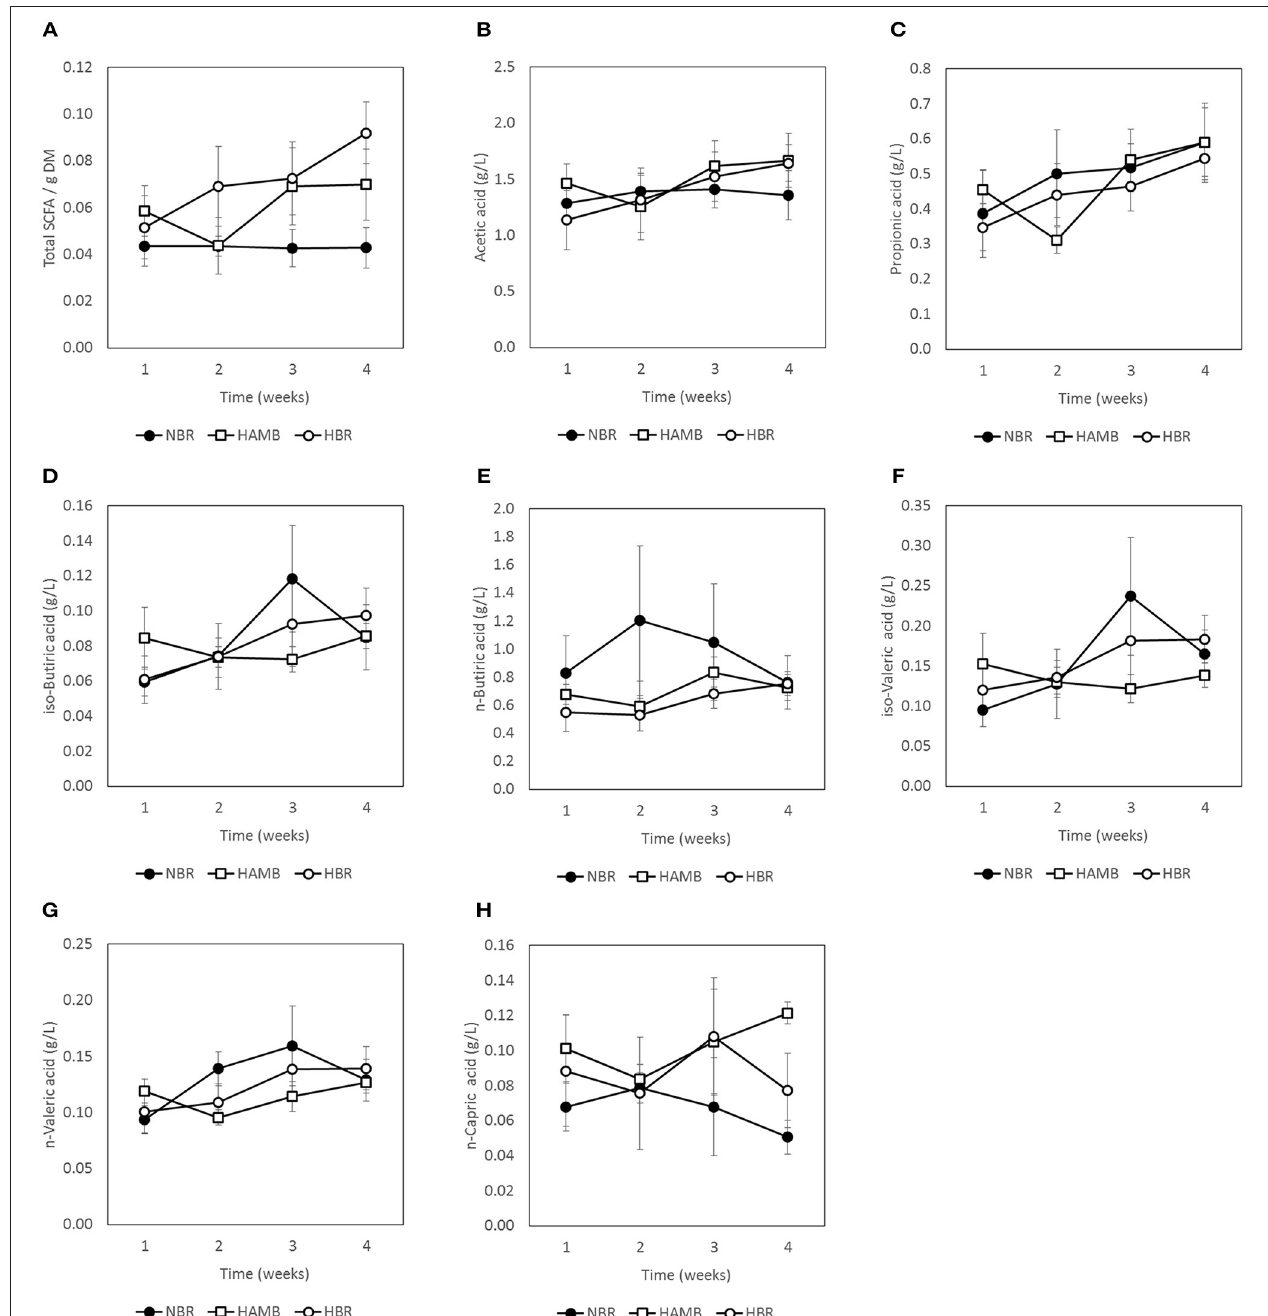
FIGURE 4 | Changes in concentration of C1–C6 short chain fatty acids (SCFA) present in fecal samples during run-in (week 1) and subsequent 3-week experimental phase: total SCFA (A) , acetic acid (B) , propionic acid (C) , iso-butyric acid (D) , n-butyric acid (E) , iso-valeric acid (F) , n-valeric acid (G) , and n-capric acid (H)